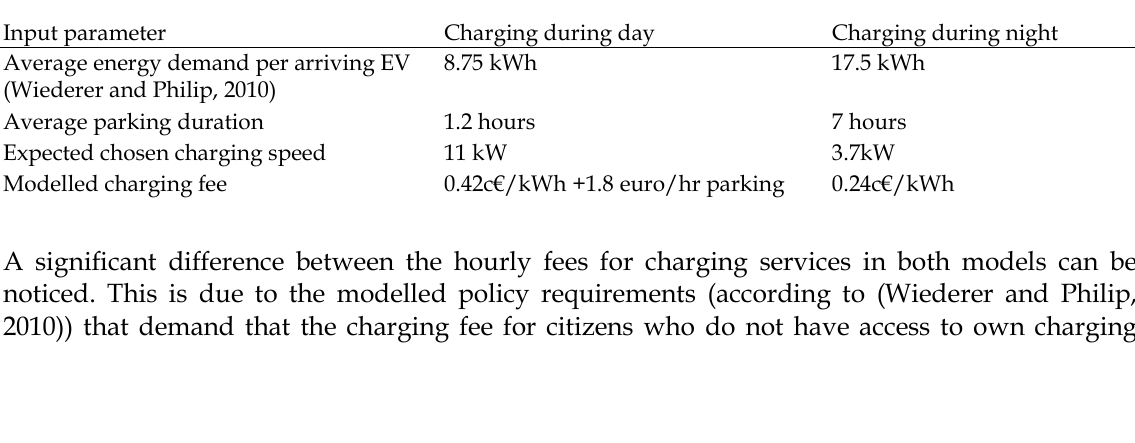
Modelled inputs for the municipal parking